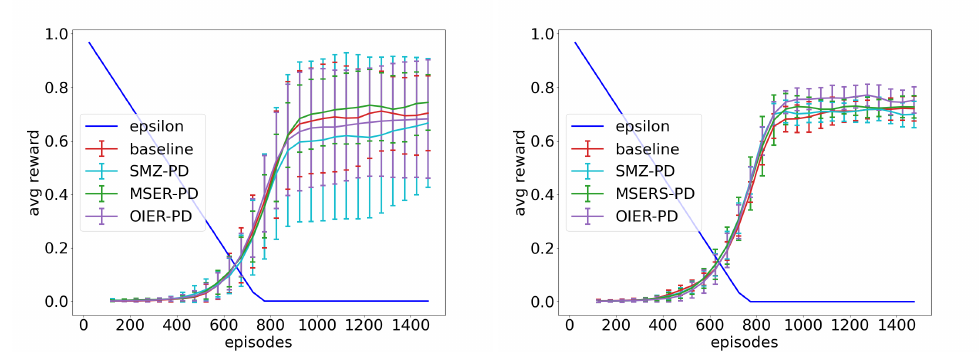
Figure A5. The results for the IER mode: PD and t expl = 750. state encoding: VE. state encoding: CE.